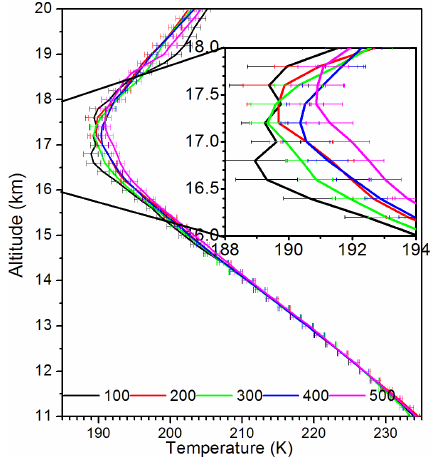
Figure 7. Mean temperature structure observed using GPS RO pro- files that occurred within 100, 200, 300, 400, and 500km from the TC centre. Horizontal bars show the standard error. For clarity, the temperature structure observed between 16 and 18km is shown in the